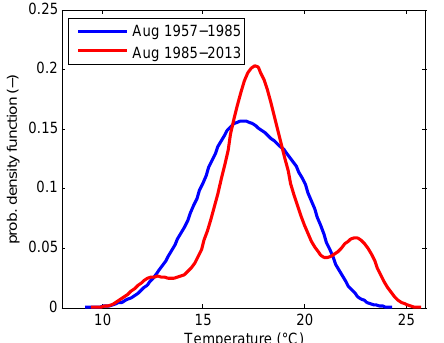
Figure 6. Normalised temperature distribution for observations at Figure6. NormalisedtemperaturedistributionforobservationsatBEinAugustforthefirsthalf(blue) BE in August for the first half (blue) and the second half (red) of andthesecondhalf(red)ofthetimeseriesatthesurfacewater(1 m ). the time series at the surface water (1m).